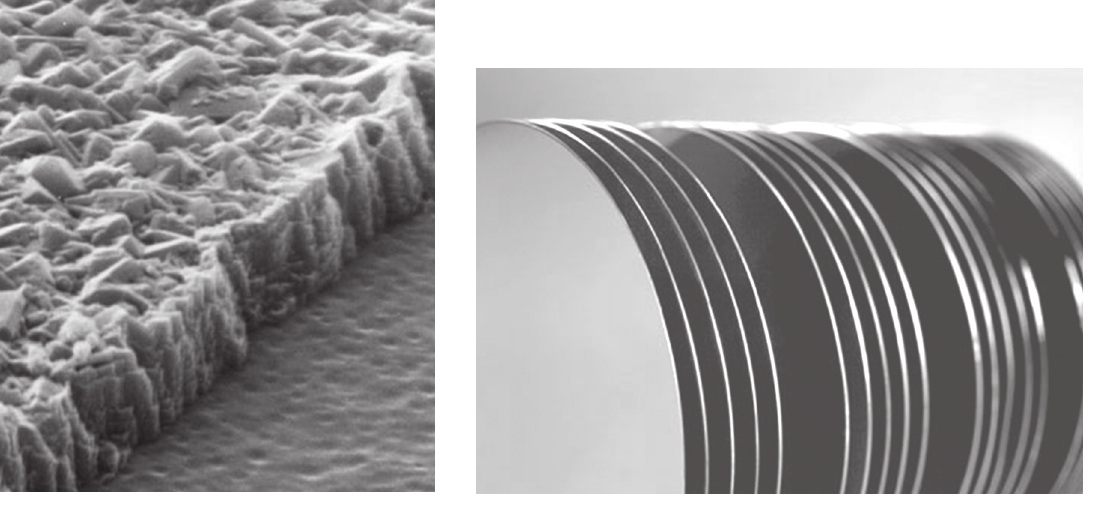
Figure 2. Picture shows diamond electrodes on a silicon substrate by CVD (Reproduced with permission from of Centre Suisse d’Electronique et de Microtechnique, Neuch ậ tel,